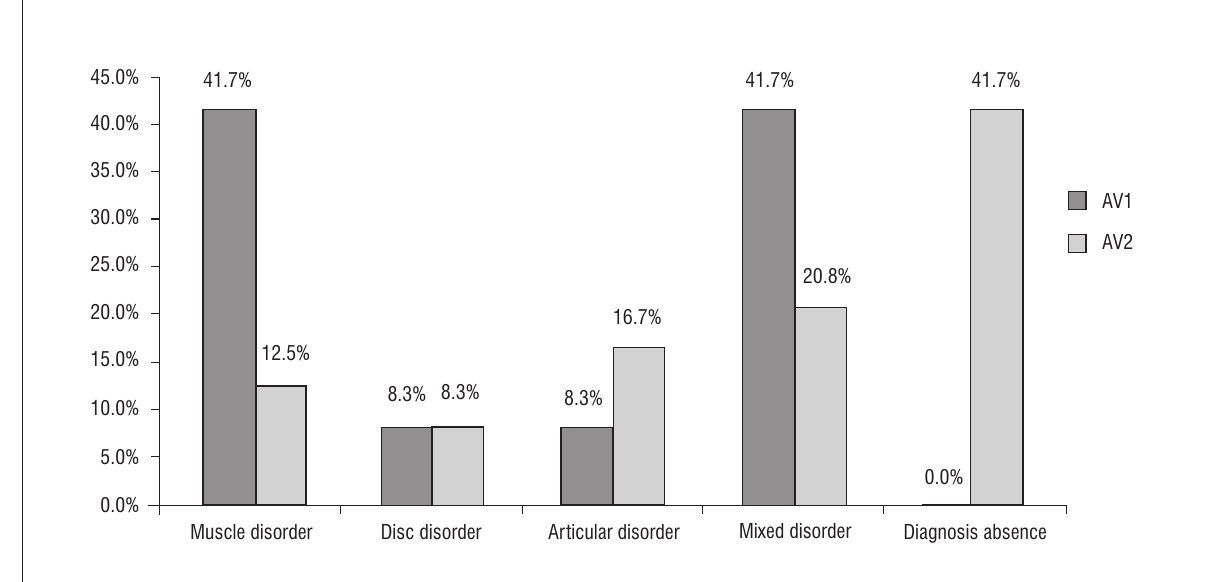
Figure 2 - Percentage distribution of diagnostic classifications of TMD according to RDC/TMD (n = 24) Source: Research data.